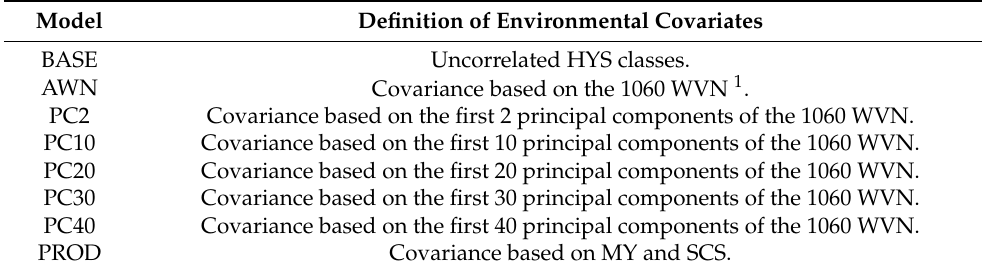
Table 3. List and definition of the environmental covariates as they were used in the 8 models. Model Definition of Environmental Covariates BASE Uncorrelated HYS